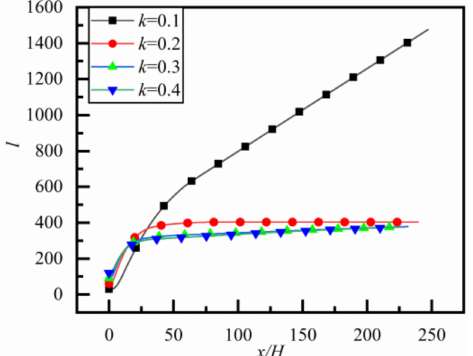
Figure 7. Changes in the spacing of a pair of single-scale particles at different blocking ratios (Re =